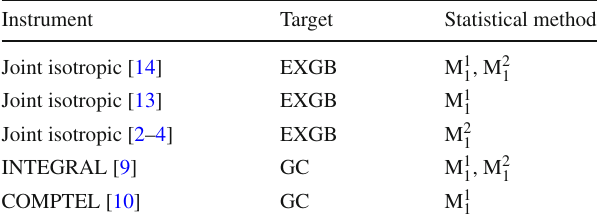
Table 4 Existing constraints classification. Joint isotropic: all or part among HEAO + balloon + SMM + COMPTEL + EGRET + Fermi- LAT instruments (ordered with increasing energy domains). EXGB: extragalactic gamma/X-ray background. GC: galactic center